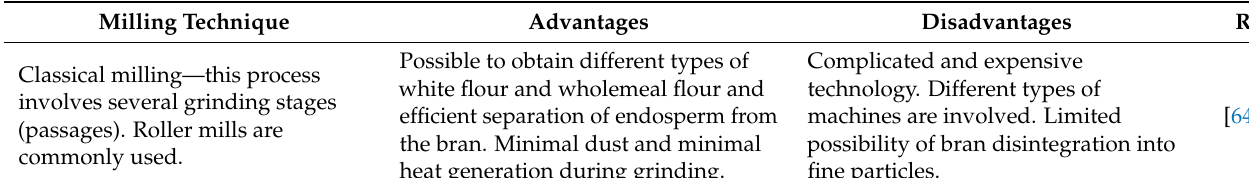
Figure 2. Modification of rye flour properties using different milling techniques. Table 1. Advantages and disadvantages of different rye milling